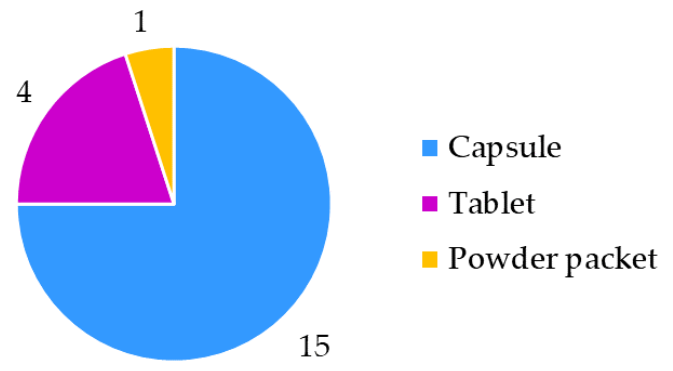
Figure 2. Forms of food supplement products.